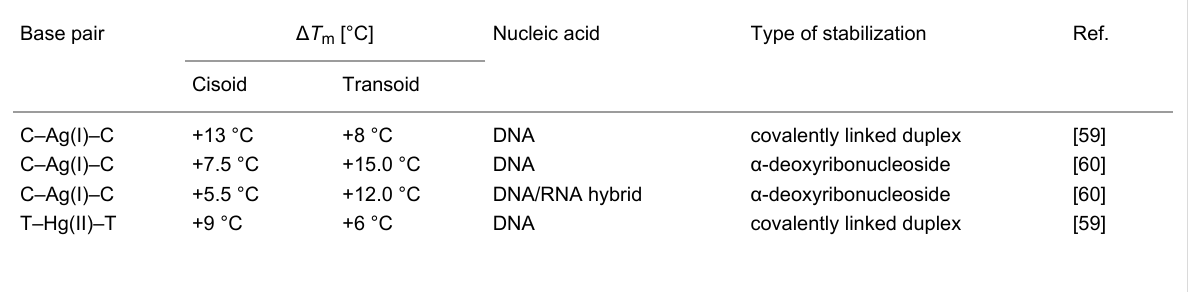
Table 1: Increase in melting temperature Δ T m of duplexes bearing C–Ag(I)–C or T–Hg(II)–T base pairs upon formation of that metal-mediated base pair.